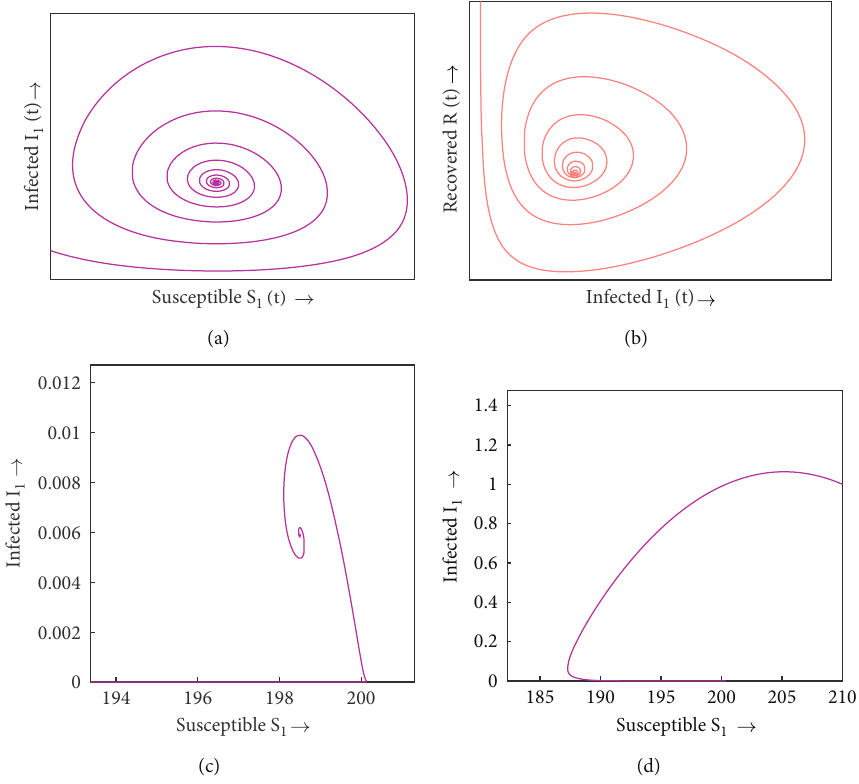
= 0 : 9 (c) for ψ = 1 : 9 and (d) for ψ 1 1